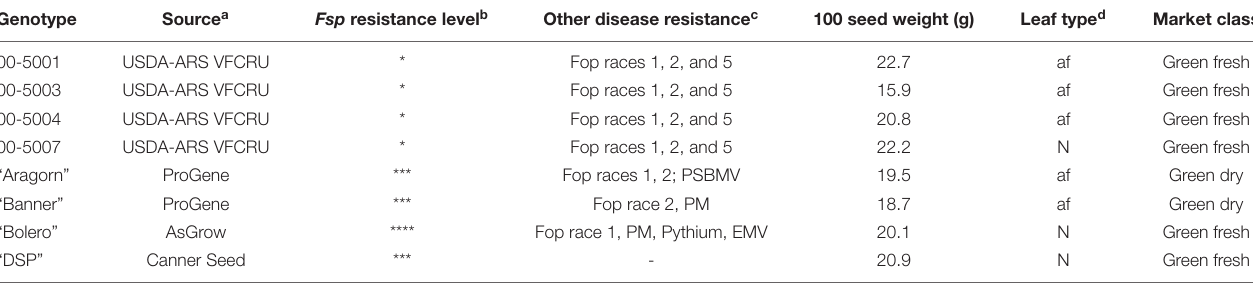
TABLE 1 | Selected green-seeded pea genotypes for SNP genotyping [Adapted from Williamson-Benavides et al. (2020)].